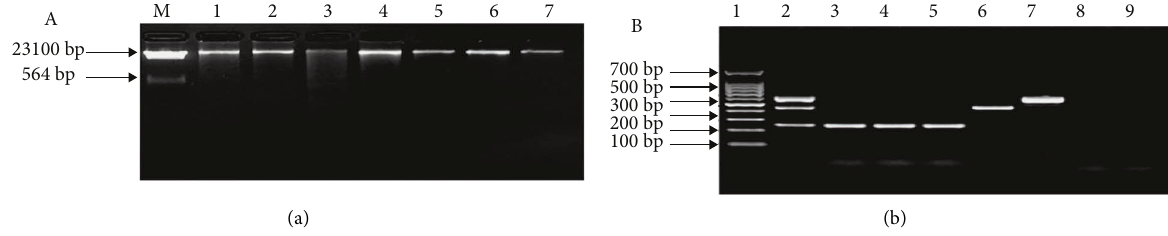
Figure 2: Agarose gel electrophoresis of genomic DNA extracts and species-specific fragments by multiplex PCR. (a) Agarose gel electrophoresis of genomic DNA extracted from different animals’ bone marrows using an SDS alkaline lysis method. M: Marker; 1 ∼ 3: BBM listed as 2016BH001, 2016BH002, and 2016BH003; 4: donkey bone marrow; 5: pig bone marrow; 6: sheep bone marrow; 7: a mixture of DNA extracted from horse and deer bone marrow (1 :1). (b) Agarose gel electrophoresis of species-specific fragments by multiplex PCR. 1: Marker; 2: a mixture of DNA extracted from three species (1:1:1); 3 ∼ 5: BBM listed as 2016BH001, 2016BH002, and 2016BH003; 6: donkey bone marrow; 7: pig bone marrow; 8: sheep bone marrow; 9: a mixture of DNA extracted from horse and deer bone marrow (1